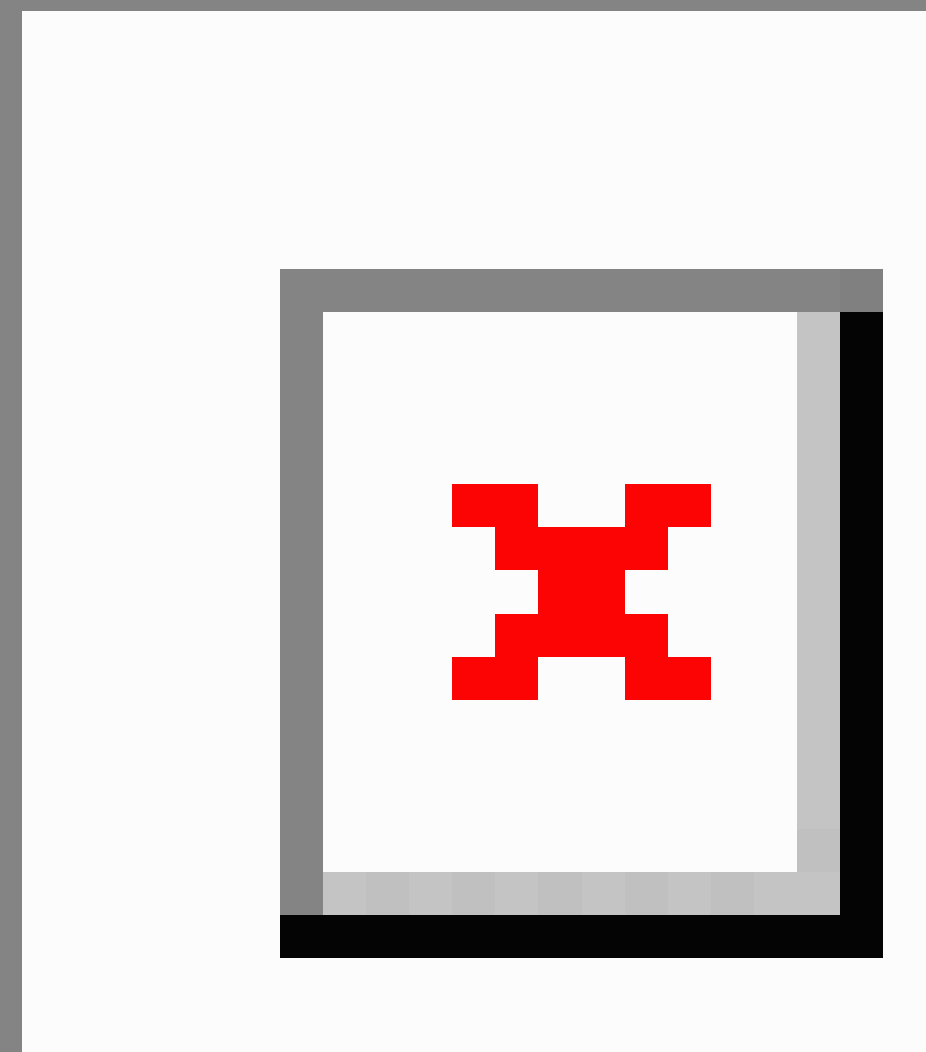
Figure 1. The cloud computing deployment